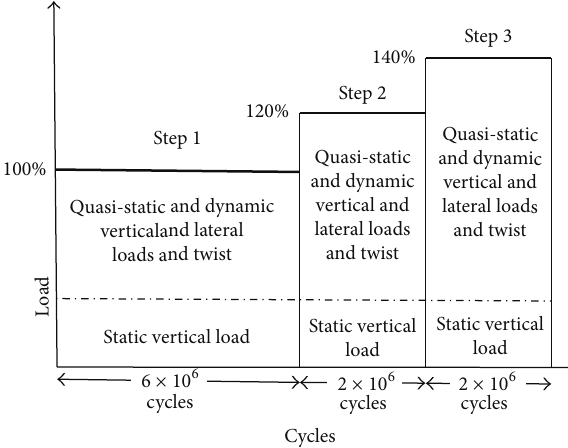
Figure 6: Step-by-step load conditions of fatigue test [6].